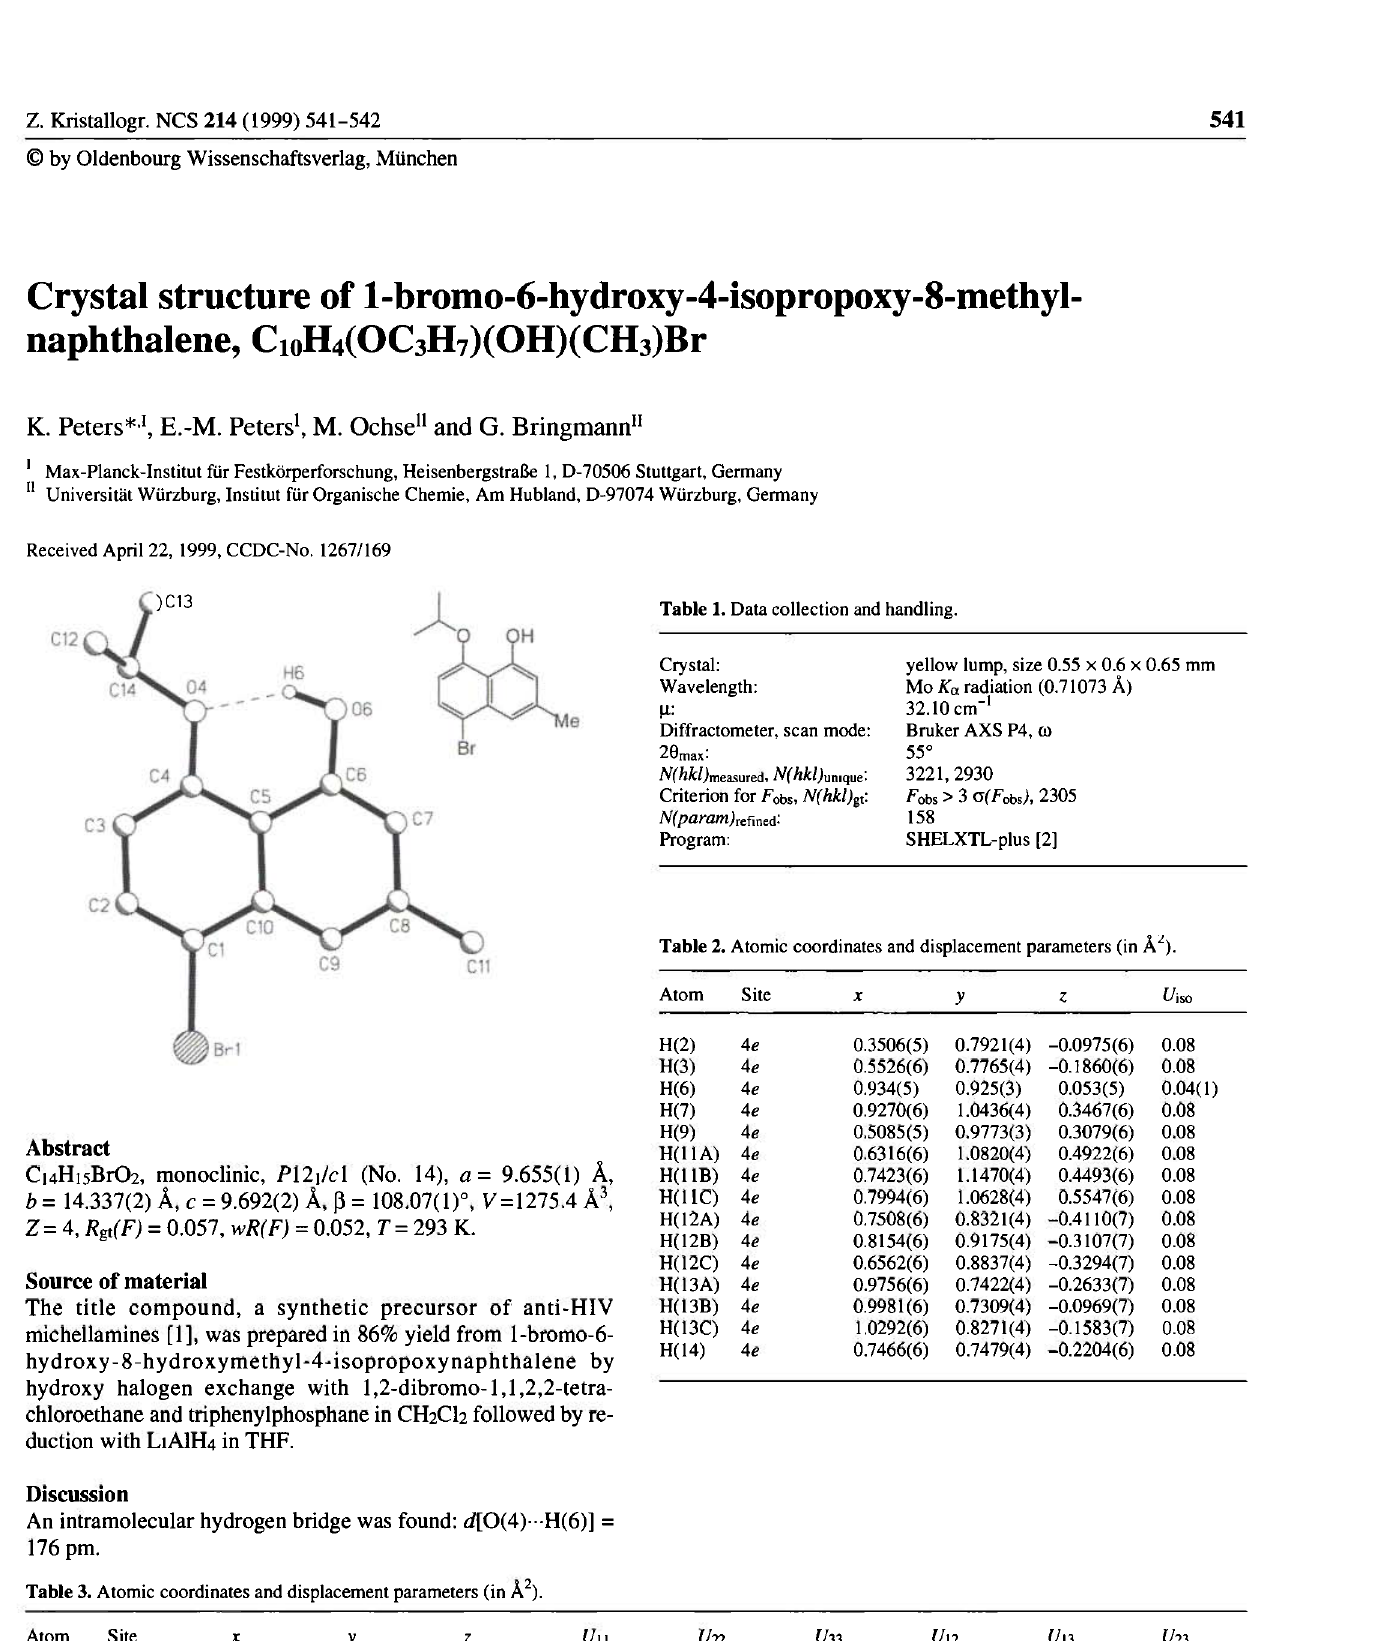
Table 3. Atomic coordinates and displacement parameters (in A 2 ).